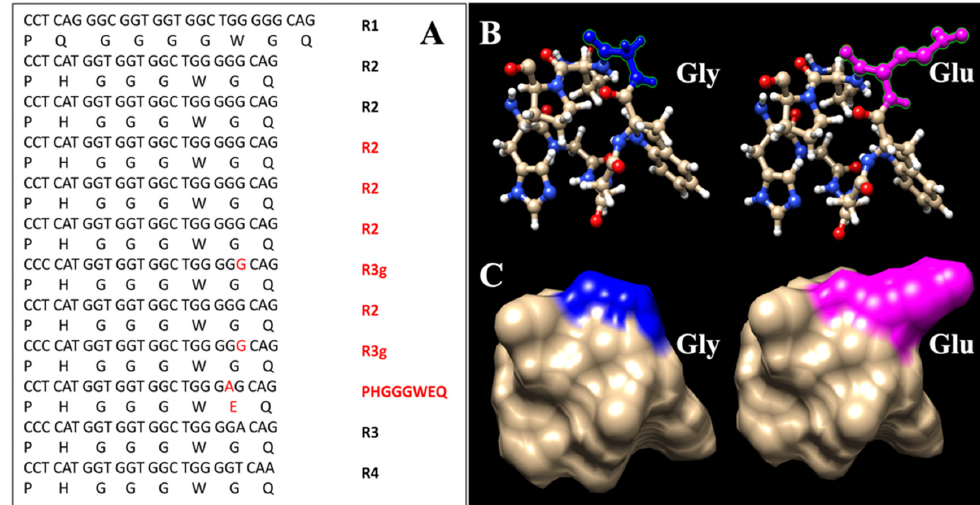
Figure 3. ( A ) Nucleotide sequence of the mutant allele in the region between codons 51 and 91 of the PRNP in our pedigree. The 7-OPRI are inserted after the second R2 cycle. The mutated nucleotide and amino acid are shown in red. ( B ) The PHGGGWGQ residues are shown as a cartoon model. The wild-type Gly residue is indicated in blue. The mutated Glu residue with acidic side chains in our patient is indicated in magenta. ( C ) These residues are shown as a surface model. The wild-type Gly residue, which has hydrophobic side chains, is indicated in blue. The mutated Glu residue found in our patient is indicated in magenta.